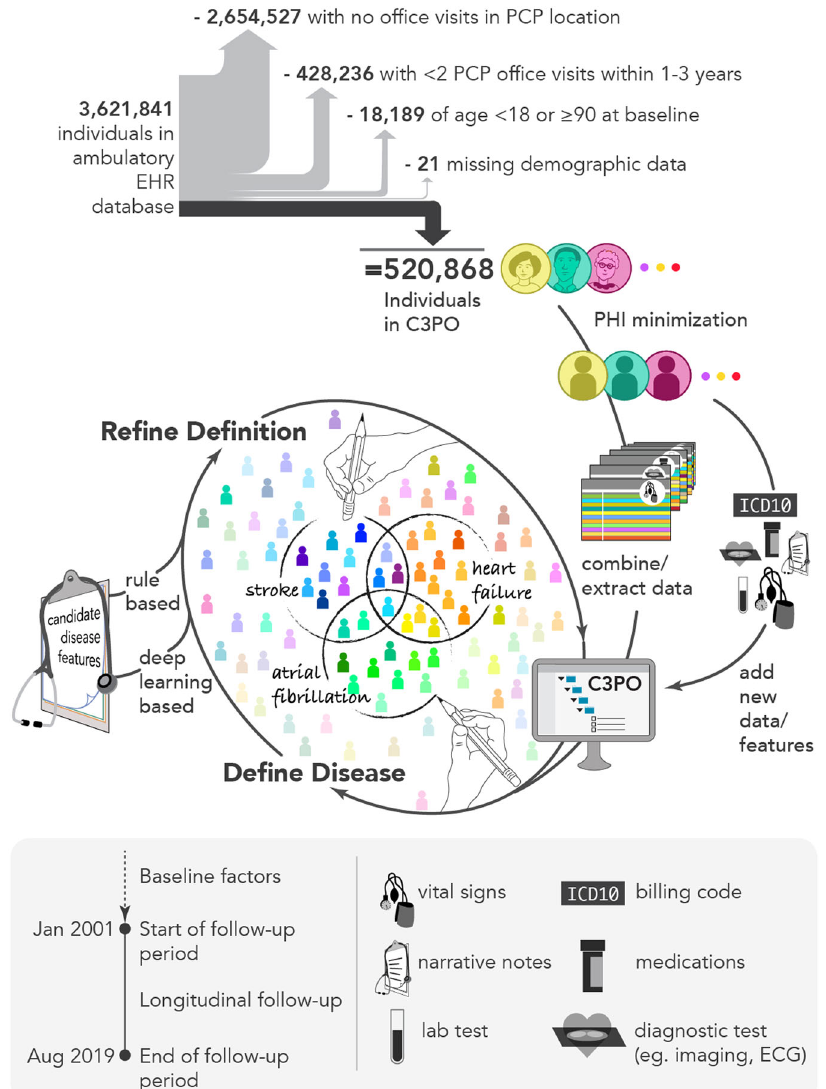
Fig. 1 Overview of C3PO construction and data pipeline. Depicted is a graphical overview of the construction of the Community Care Cohort Project (C3PO). C3PO comprises the electronic health record (EHR) data of 520,868 individuals aged 18 – 90 at the start of sample follow-up, selected from an ambulatory EHR database on the basis of receiving periodic primary care (i.e., ≥ 2 visits within 1 – 3 consecutive years, see text). C3PO is structured as an indexed fi le system containing protected health information-minimized data of various types (bottom panel). The C3PO database can readily accommodate updating of existing data, integration of new data features, and construction of composite disease phenotypes based on multiple data